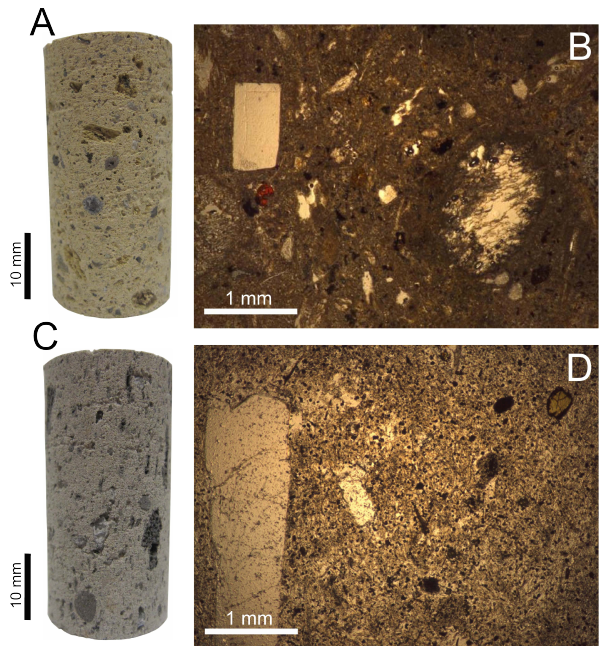
Fig. 2. Photographs and optical microscopy images of the as- collected Neapolitan Yellow Tuff ( A and B ) and Grey Campanian Ignimbrite ( C and D ). The photomicrographs are taken from Heap et al.